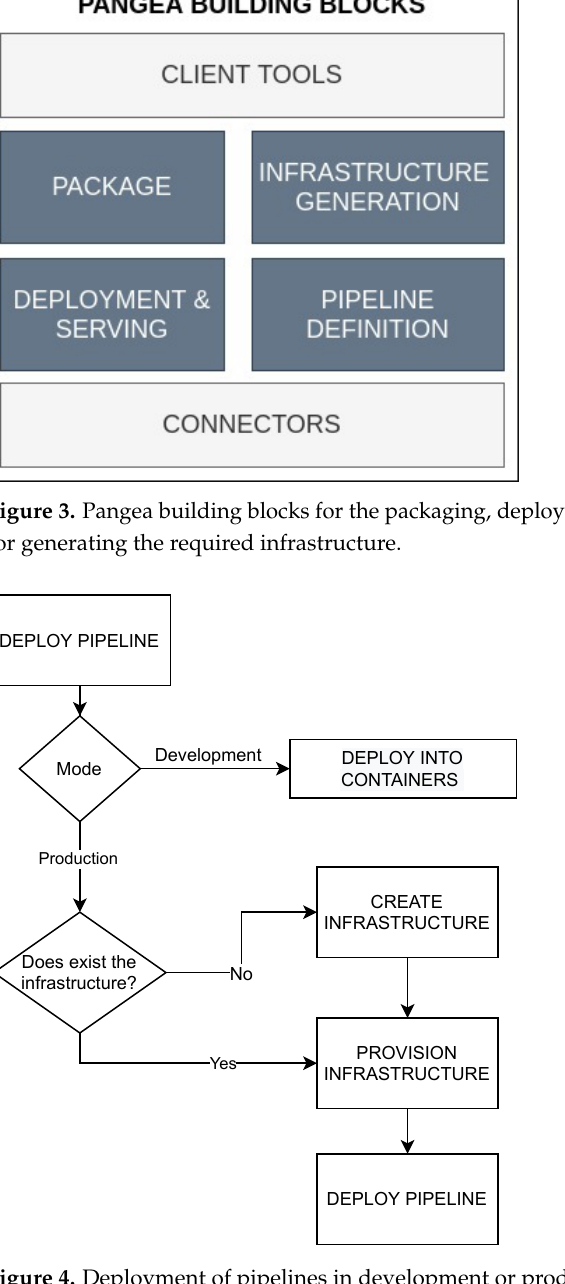
Figure 4. Deployment of pipelines in development or production with